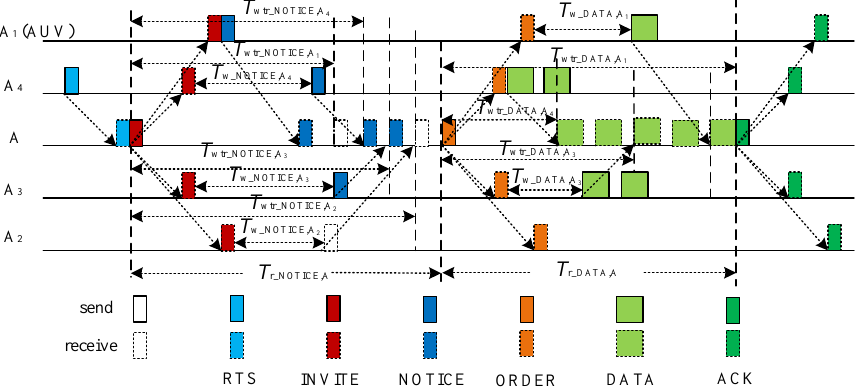
Figure 5. The process of data transmission in the contention-based MAC (CT-MAC) protocol.